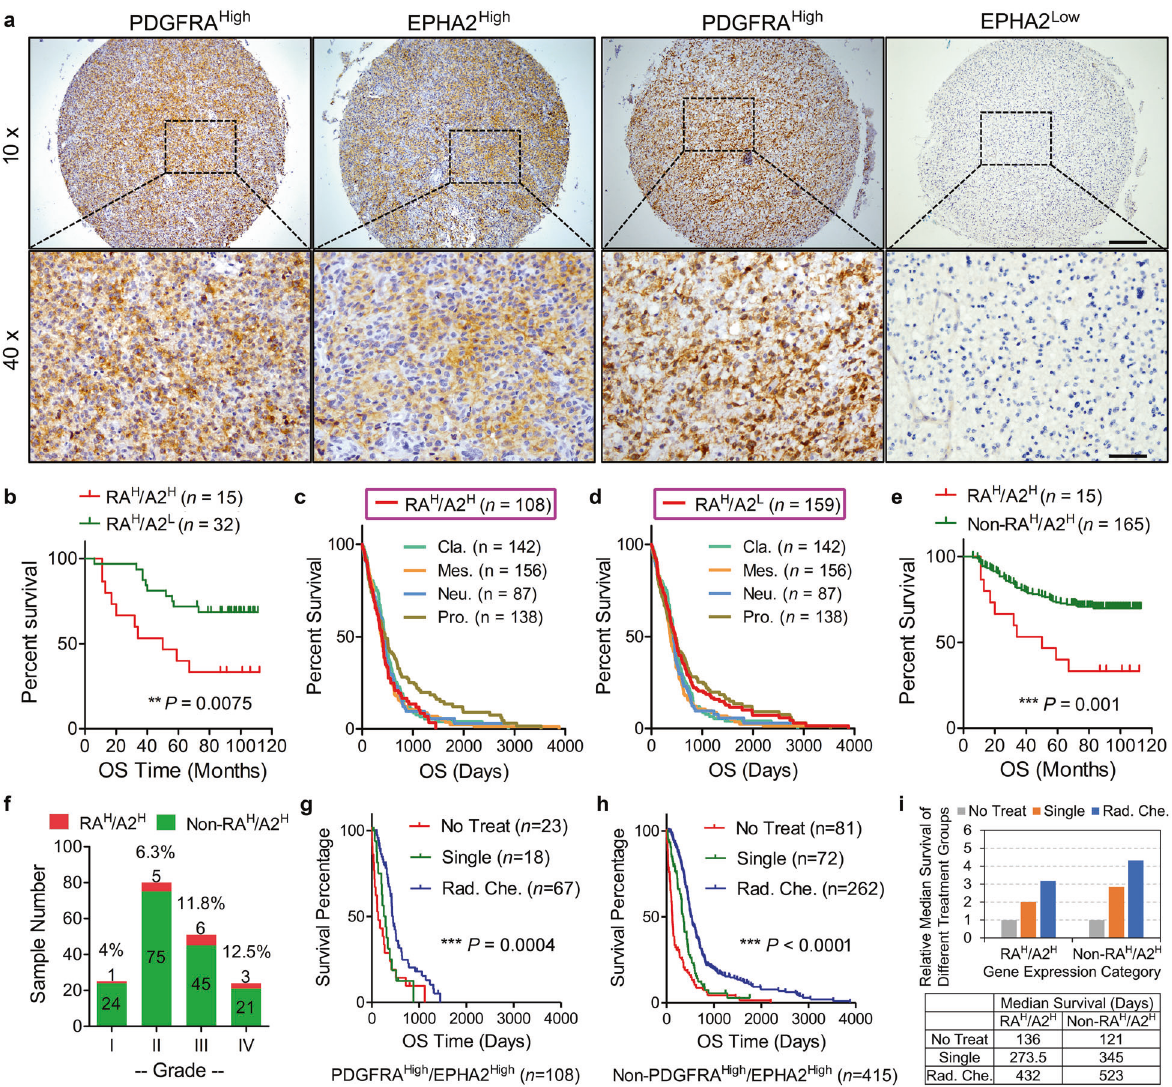
Fig. 5 Clinical signi fi cance of EPHA2 and PDGFRA in GBM. a Representative immunohistochemistry images of EPHA2 and PDGFRA proteins on continuous tissue sections. Scale Bar = 200 μ m (upper) and 50 μ m (lower). b Kaplan – Meier survival analysis on cases with PDGFRA High / EPHA2 High vs. PDGFRA High /EPHA2 Low from our glioma cohort. c Survival curve comparison between cases with PDGFRA High /EPHA2 High and different molecular subtypes according to TCGA_GBM mRNA expression dataset. d Survival curve comparison between cases with PDGFRA High /EPHA2 Low and different molecular subtypes according to TCGA_GBM mRNA expression dataset. e Kaplan – Meier survival analysis on cases with PDGFRA High /EPHA2 High vs. all other cases from our glioma cohort. f Case count with different protein expression patterns from our glioma cohort according to tumor grades. g , h Kaplan – Meier survival analysis of different treatment ways under speci fi c gene expression patterns according to TCGA_GBM database. i Therapeutic effects of treatment ways on survival time of patients with speci fi c gene expression